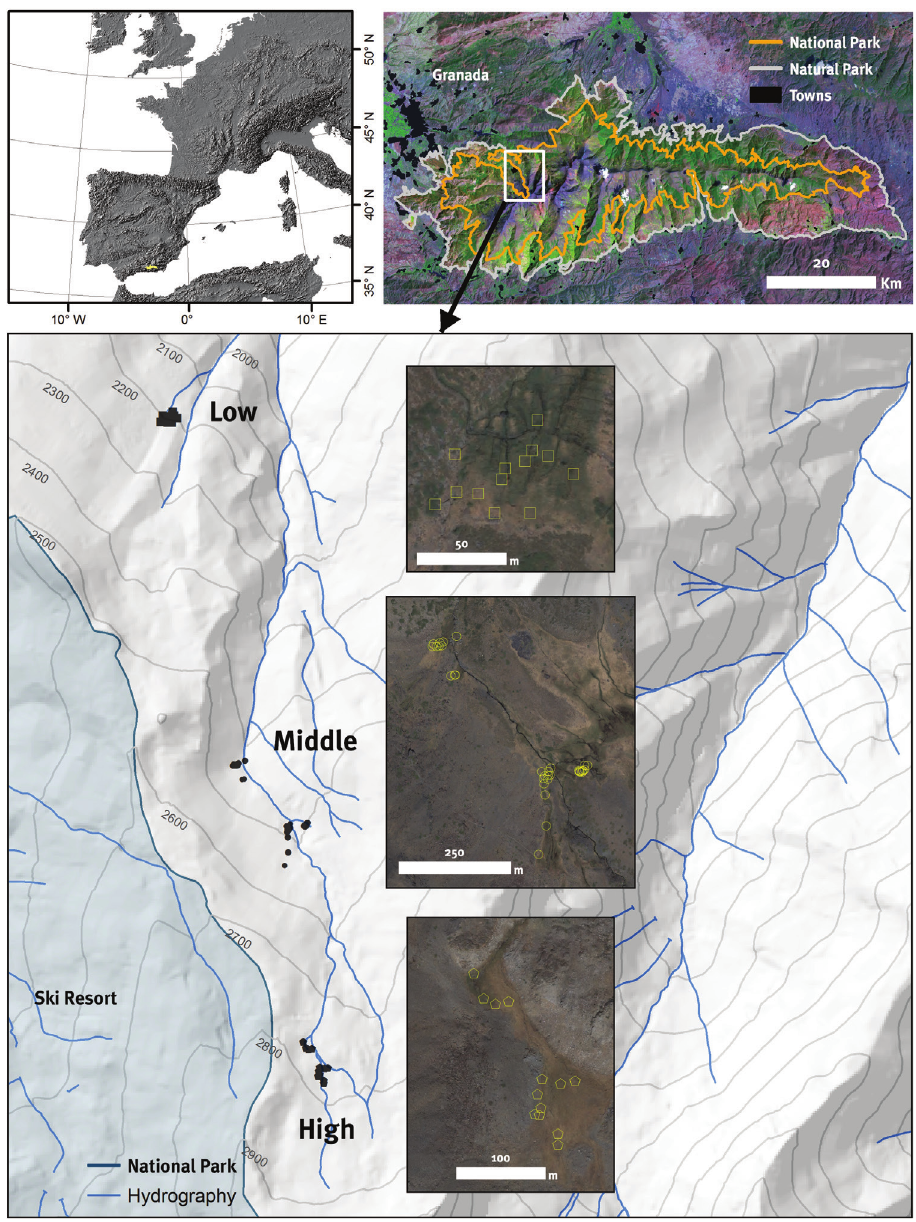
Figure 1. Location of Sierra Nevada (southern Spain) and boundaries of the National and Natural Parks (top panels). The bottom panel shows the location of the borreguiles in the San Juan river basin with the sampling plots along an altitudinal